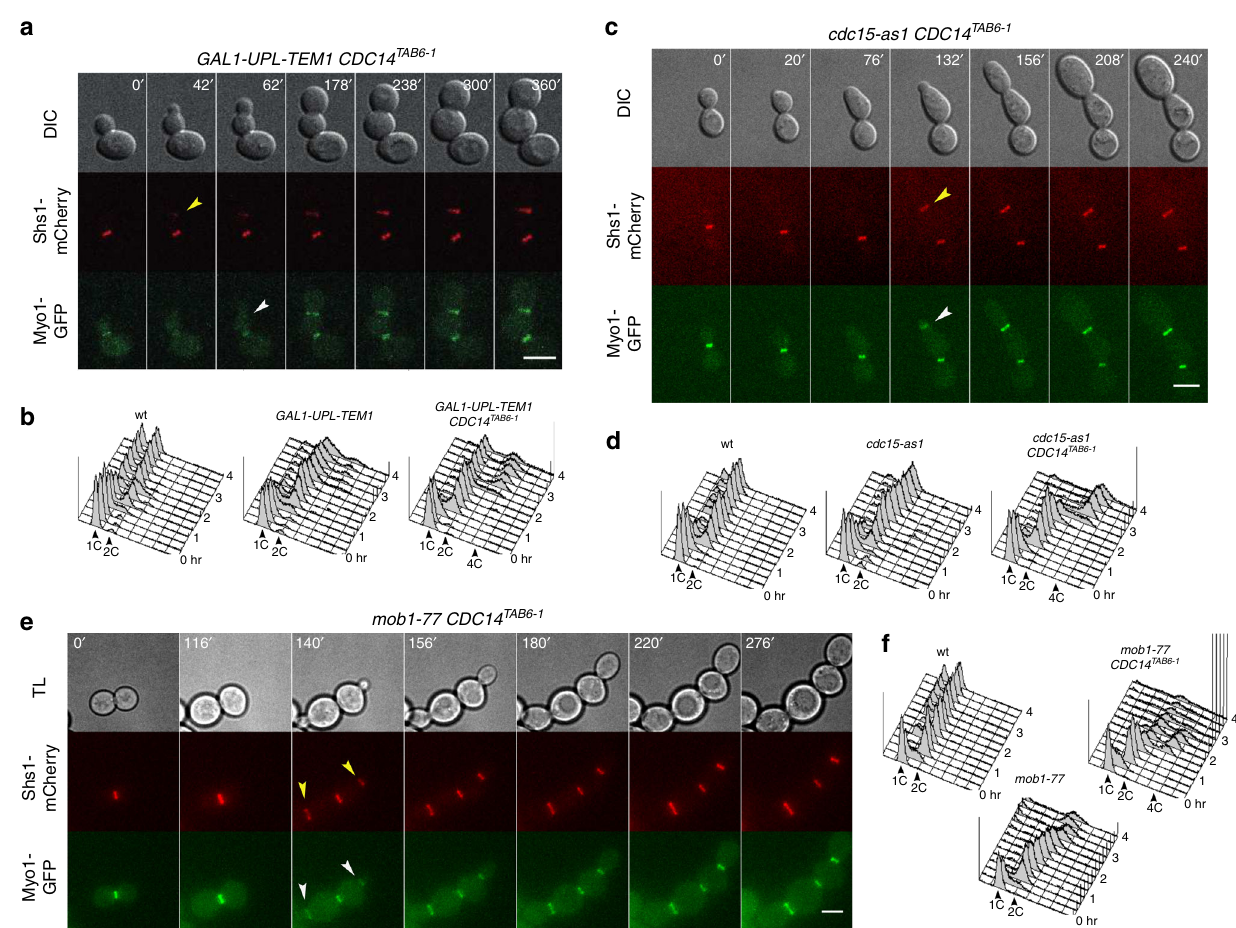
Fig. 2 The MEN factors Tem1, Cdc15, and Mob1 are required for septin ring splitting and CAR contraction independently of mitotic exit. a , c , e Cells with the indicated genotypes were grown in permissive conditions and then shifted to restrictive conditions 60 – 90 min prior to imaging. Cells were fi lmed every 2 min ( a ) or 4 min ( c , e ) for 4 – 8 h in restrictive conditions ( a glucose-containing medium; c medium supplemented with 5 µ M 1NM-PP1; e 32 °C). Arrowheads indicate the appearance of new septin rings (yellow) or CARs (white) before the old structures have been disassembled. DIC differential interference contrast. TL transmitted light. Scale bar: 5 µ m. b , d , f Cells with the indicated genotypes were grown in permissive conditions ( b YEPRG; d , f YEPD) at 25 °C, arrested in G1 with alpha factor and then released in restrictive conditions ( b YEPD; d YEPD containing 5 µ M 1NM-PP1; f YEPD at 32 ° C). At various time points after release (time 0) cells were collected for FACS analysis of DNA contents. FACS data were plotted after gating out the